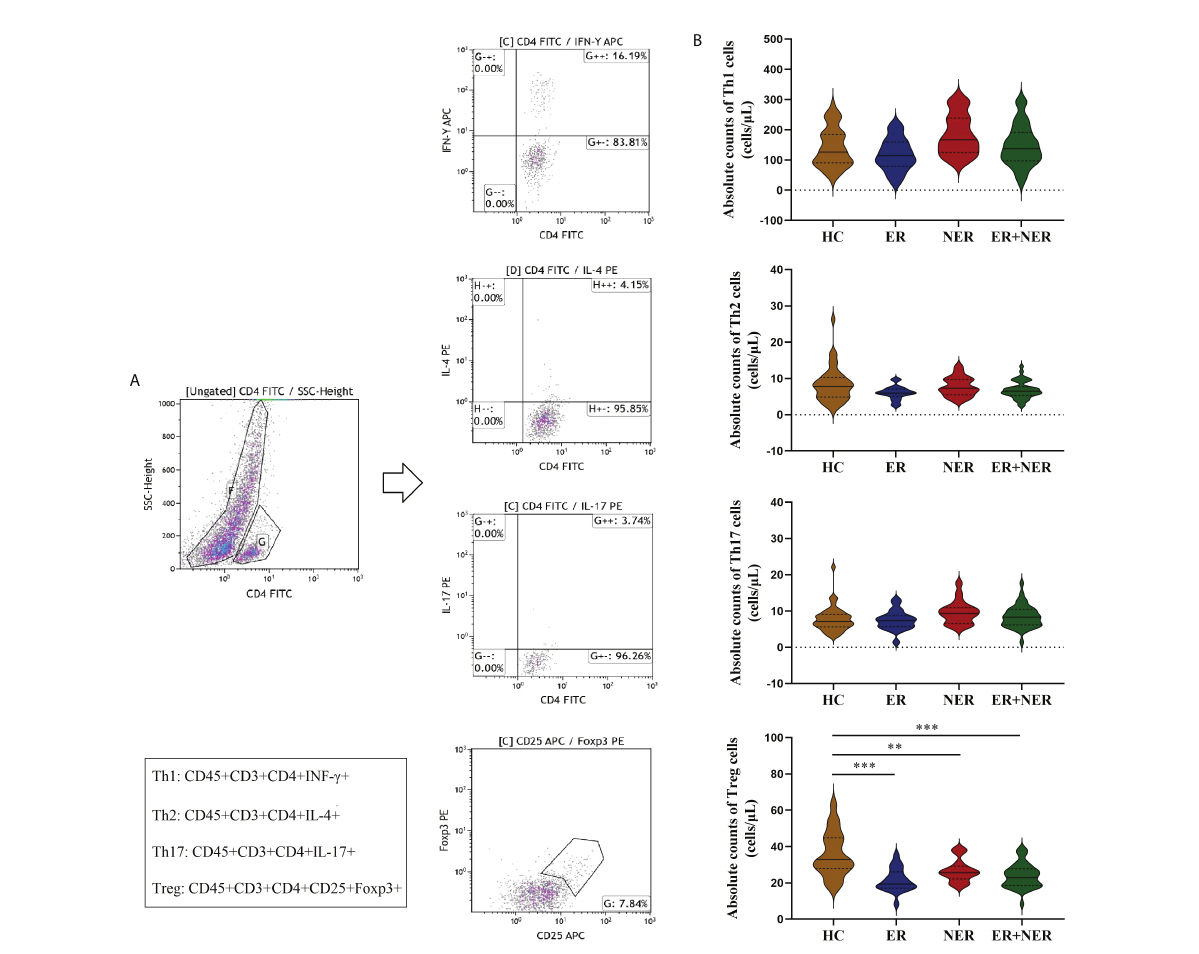
FIGURE 2 Comparative analysis of circulating CD4 + T cell subsets (Th1, Th2, Th17, and Treg cells) between patients with ER, NER, and all DTC patients (ER + NER) before RAIT and HC. (A) Flow cytometric analysis of representative CD4 + T cell subsets. (B) The absolute counts of circulating CD4 + T cell subsets in each group of patients before RAIT. ER, excellent response; NER, non-excellent response; RAIT, radioactive iodine treatment; DTC, differentiated thyroid cancer; HC, healthy controls. ** p < 0.01, *** p <